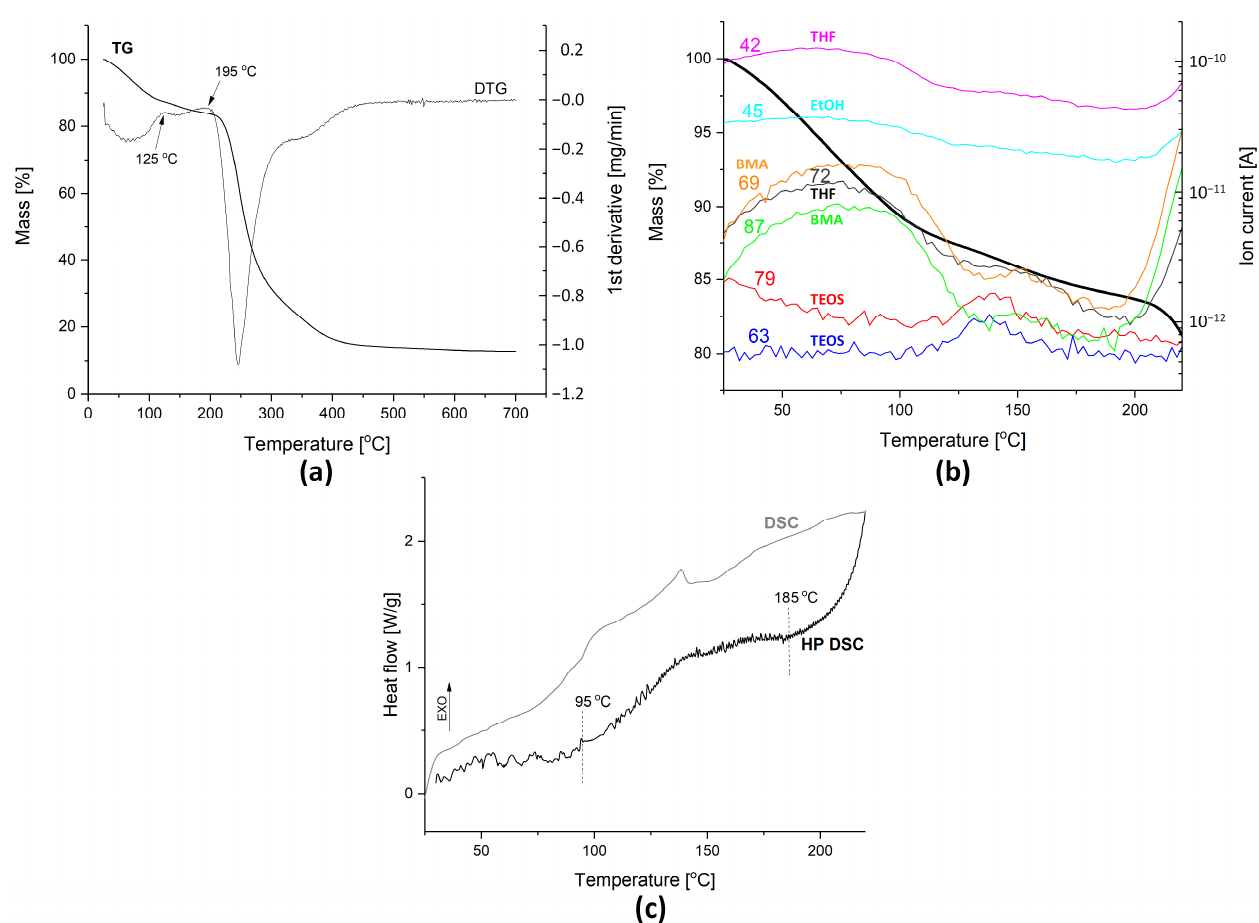
Figure 1. ( a ) TG and DTG curves of the sample PBMA-siloxane under an air atmosphere with a fl ow rate of 50 mL/min and a heating rate of 10 °C/min; ( b ) MS analyses of evaporated compounds (num- bers on the curves of di ff erent colours denote m / z values, as discussed in the text) with the TG curve added as a reference (black curve); and ( c ) comparison of a DSC curve, performed under ambient pressure and HP DSC curve performed at a pressure of 50 bars of PBMA-siloxane dried sol under static air atmosphere.